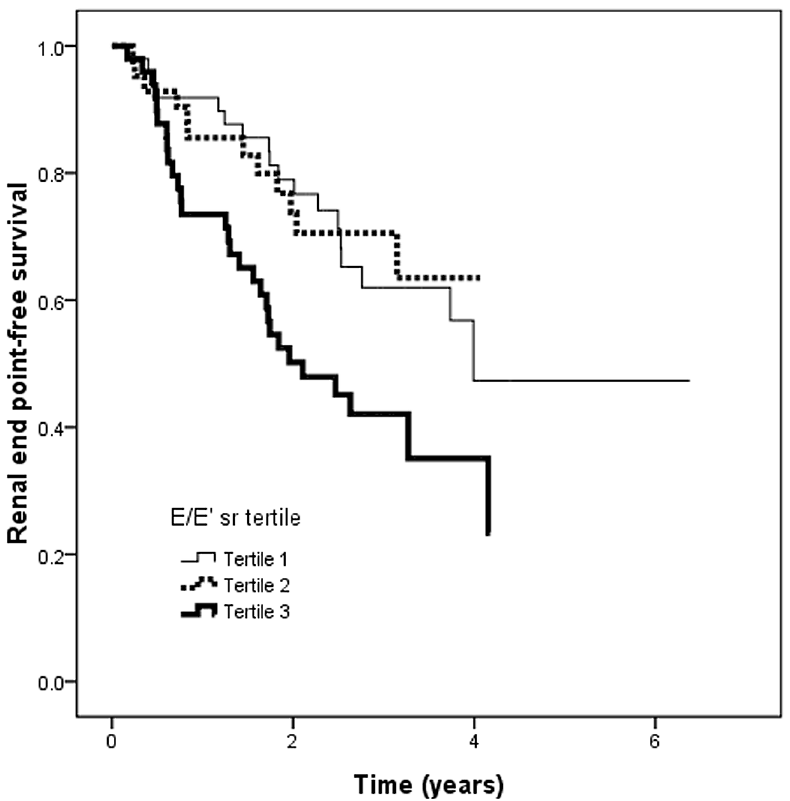
Fig 1. Kaplan-Meier analysis of renal end point-free survival according to tertiles of E/E ’ sr ratio (log- rank p = 0.008). Patients with tertile 3 of E/E ’ sr ratio had a worse renal end point-free survival than those with tertile 1 of E/E ’ sr